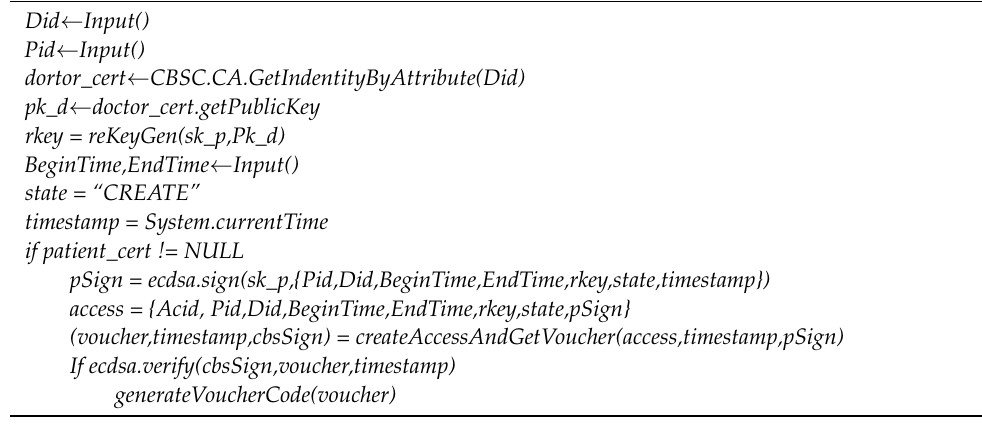
Algorithm 5. The chaincode of the pseudo-code of the generation of re-encryption key and access voucher.